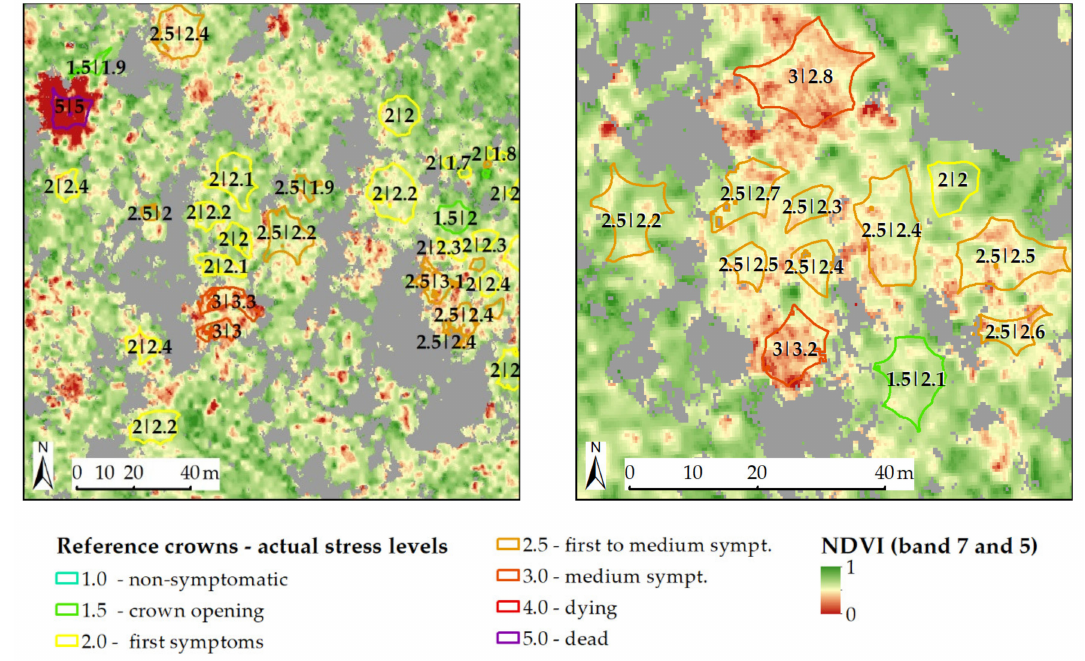
Figure 11. Maps showing reference crowns in two forest stands in the Cascade area. The labels indicate the actual stress levels (left number) and the predicted stress levels (right number) on an NDVI background raster (bands 5, 7). The predicted values are based on the seven-level reference scheme with WV2 attributes according to Table